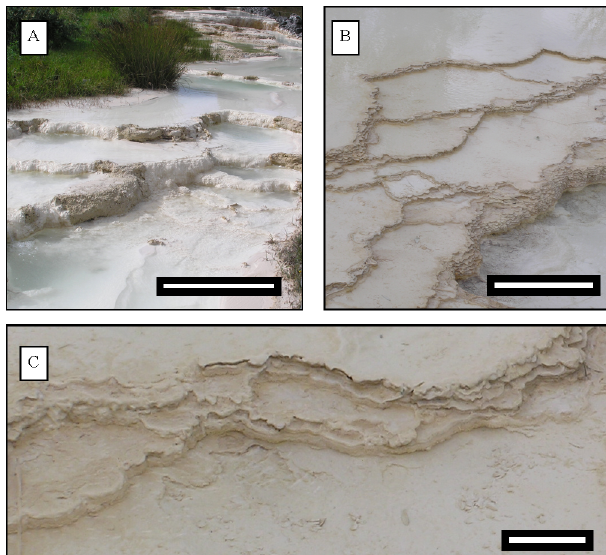
Figure 6. Low temperature, high ∆ G r . (A) Terrace and pool mor- phology in an active ambient temperature deposit. Note the large volume of lime mud within the pools. Scale bar is 1m long. Brook Bottom, near Buxton, Derbyshire, UK. (B) Detail of the terracettes developed in gentle gradient sites. Note how the large upstream pools progressively overstep the smaller downstream features and progressively encourage the development of steps. Scale bar is 0.5m long. Active, Brook Bottom, near Buxton, Derbyshire, UK. (C) Fine detail of the narrow pool rims and spillovers. Scale bar is 100mm long. Brook Bottom, near Buxton, Derbyshire, UK.